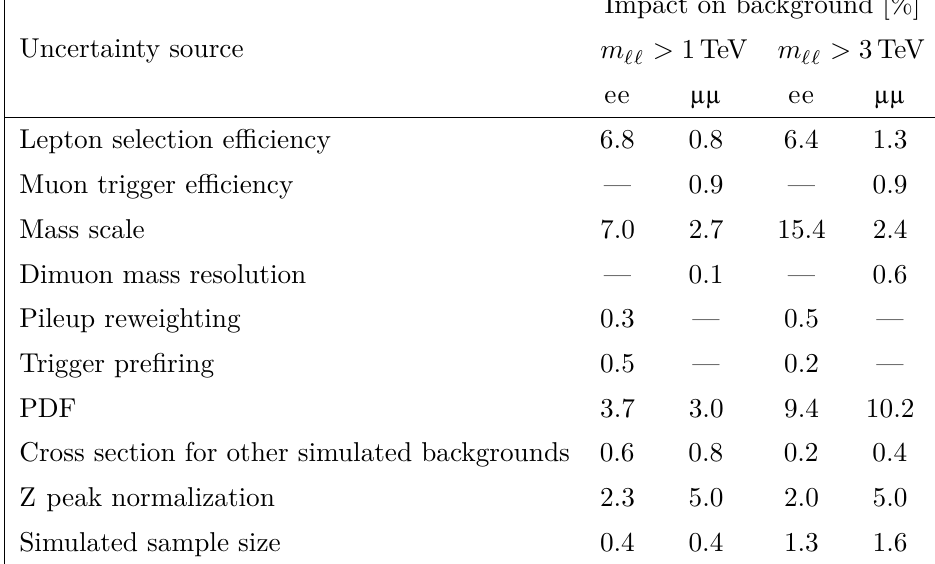
Table 3 . Systematic uncertainties considered in the search for nonresonant signals. The relative impact of the uncertainties on the background yield estimates is shown for two dilepton invariant mass thresholds, 1 and 3 TeV. The uncertainty in the jet misidentification background has a negli- gible effect on the overall background estimate and is not